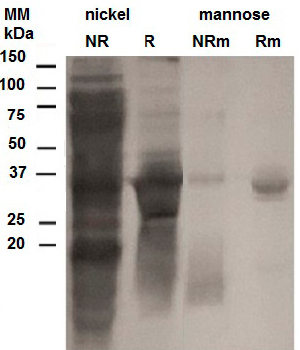
Figure 2. Recombinant Trx-rHelja purification by affinity chromatography. The protein profile of samples collected during Trx-rHelja purification scheme was analyzed using sequentially affinity for Ni 2+ -Sepharose and mannose-agarose matrixes. The soluble fraction (SN) of extracts from 100 mL IPTG induced E. coli cultures were loaded on the metal affinity matrix and the non-retained (NR) or the retained (R) fractions were recovered. Then, R was loaded on a mannose-agarose column and the proteins, the non-retained (NRm), and retained peaks (Rm) were recovered. Aliquots of R, NR, Rm and NRm fractions were analyzed in 12% SDS-PAGE and subsequently stained with Coomassie Brillant Blue. Figure is representative of two ( n = 2) independent experiments. Molecular mass markers are indicated on the left.